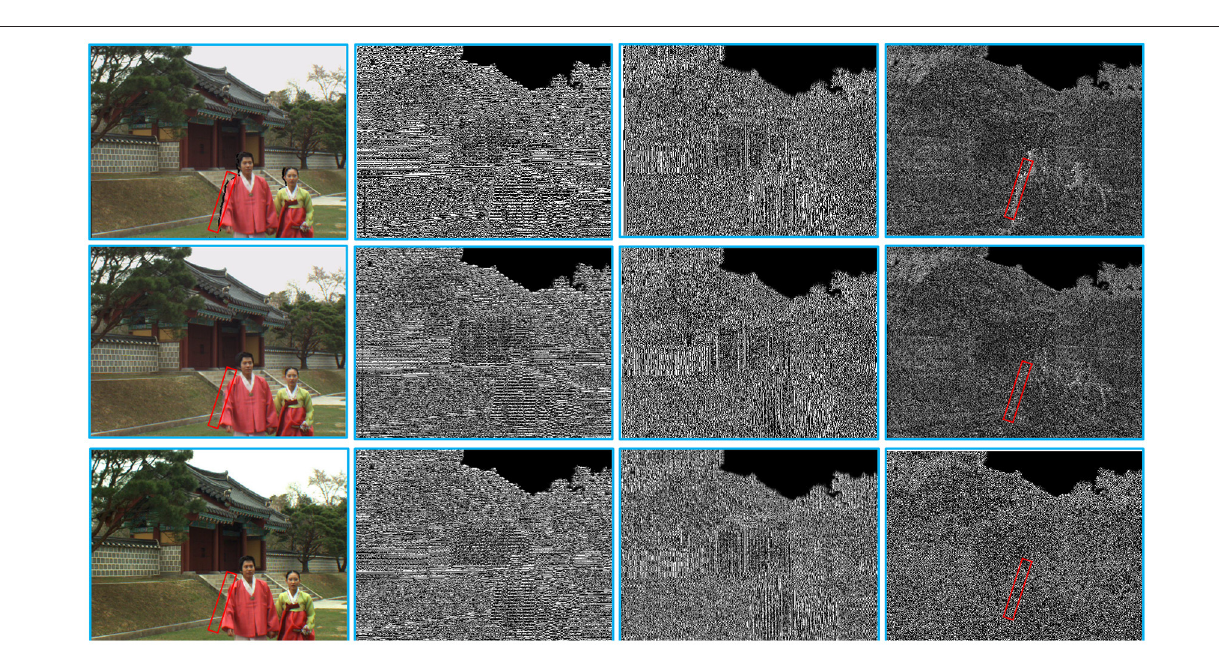
FIGURE 3 | Examples of the high-frequency wavelet subbands (i.e., HL, LH, and HH subbands) of two synthesized images and their reference image. From left to right, the images in each row are a synthesized/reference image and its corresponding HL, LH, and HH wavelet subbands. Note that the synthesized image of the first row has only the warping